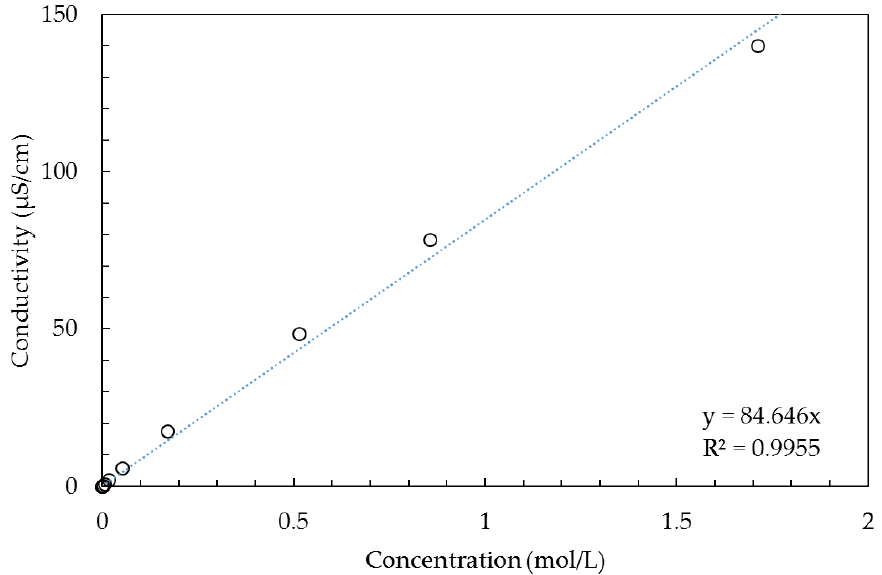
Figure 2. Conductivity of NaCl solutions with regression line forced through the origin; data from [54]. Table 1. R 2 of the fit K = a∙C as function of maximum concentration.